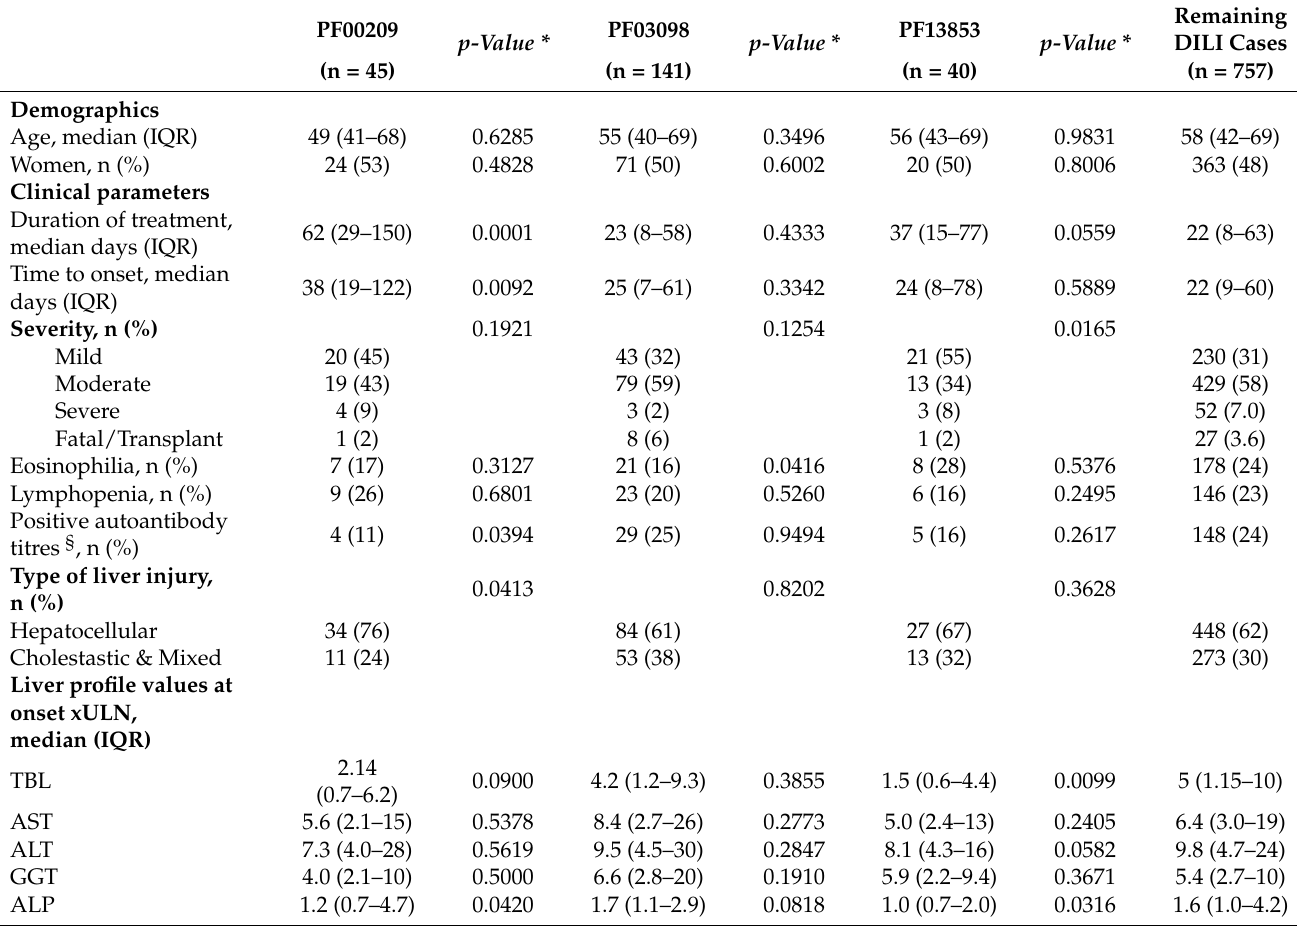
Table 2. Drug communities and therapeutic groups of DILI